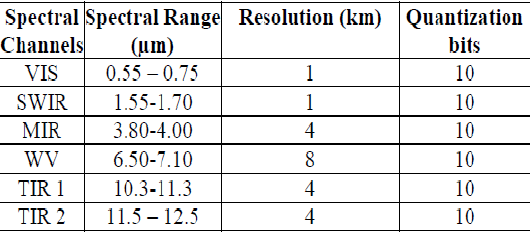
Table 1. Payload specification for INSAT-3D imager